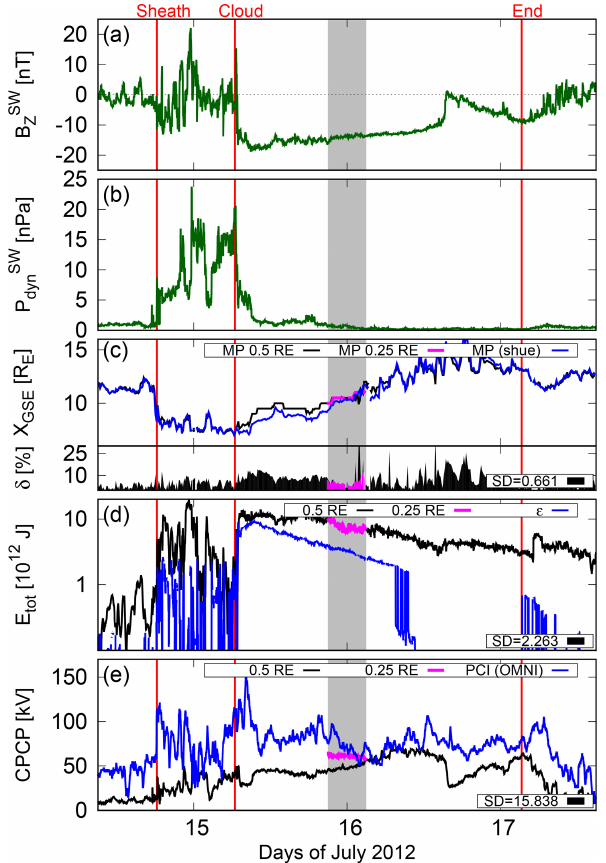
Figure 7. (a) Interplanetary magnetic field Z component, (b) so- lar wind dynamic pressure, (c) distance to the nose of the magne- topause, (d) energy transferred from the solar wind into the magne- tosphere through the dayside magnetopause, and (e) the cross-polar cap potential during 30 April 00:00–06:00UT, 2014. Magenta plots in panels (c) – (d) show results with a maximum spatial resolution of 0.25 R E . Blue curves in panels (c) , (d) , and (e) show the reference values (the Shue model, the (cid:15) parameter, the PCI). The relative dif- ference magnitude δ between GUMICS-4 and the reference value is shown in panel (c) . SDs for reference vs. GUMICS-4 (0.5 R E reso- lution) datasets are given in panels (c) – (e)